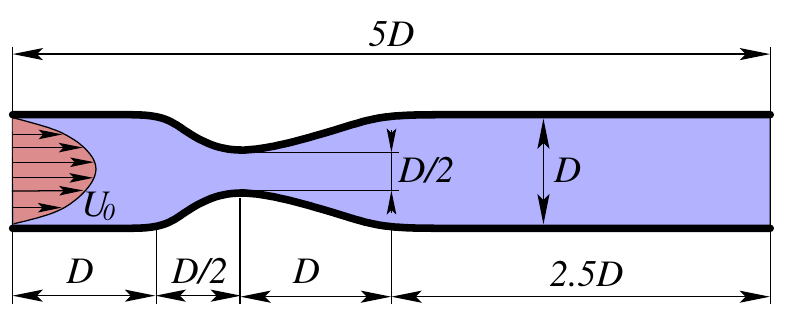
Figure 9. Computational domain.